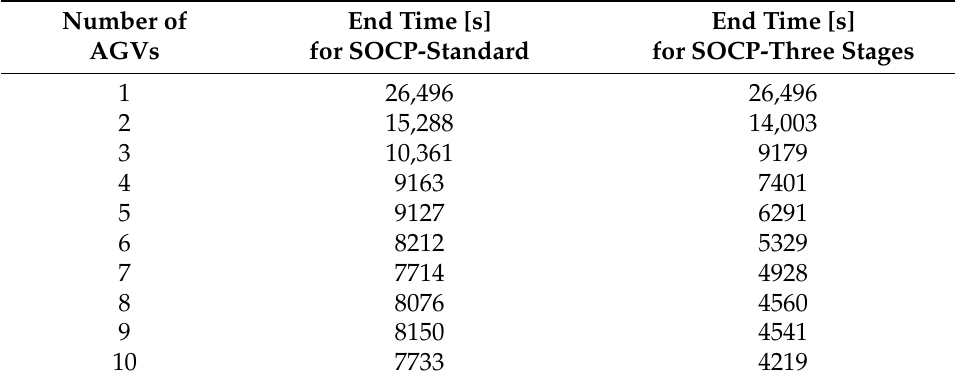
Table 4. The results of the simulation (mixed paths).